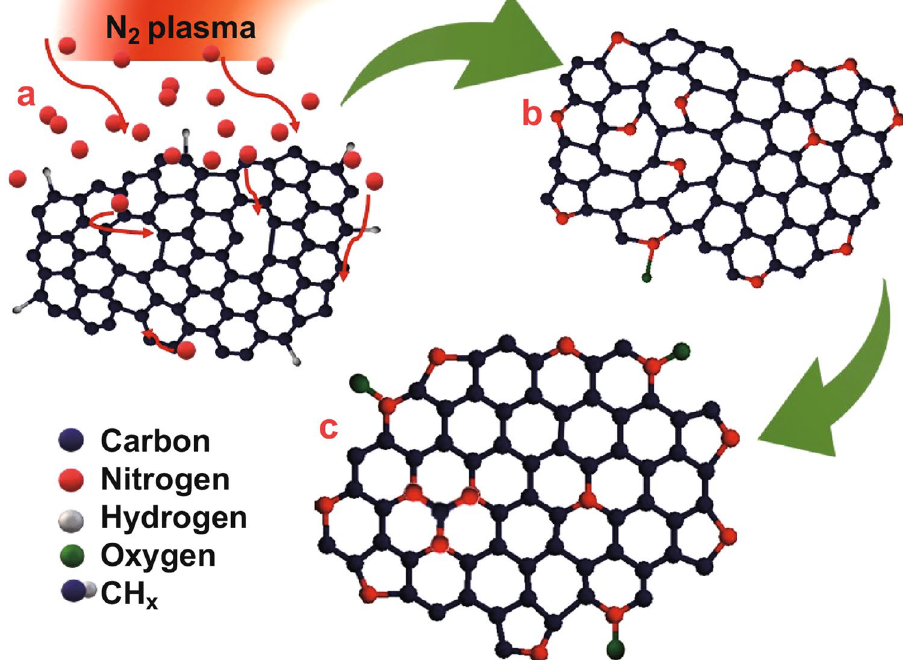
Fig. 7 Schematic diagram of the possible mechanism of nitrogen incorporation in CNWs by N 2 plasma post-treatment: a the interaction of plasma species with defects, b the substitution of N-atoms in the SV to form graphitic N and incorporating N at DV to form pyridinic N, and lastly c the transformation of pyridinic N to graphitic N by the bond rotation at DV and formation of oxidised pyridinic N groups by ex situ adsorption of